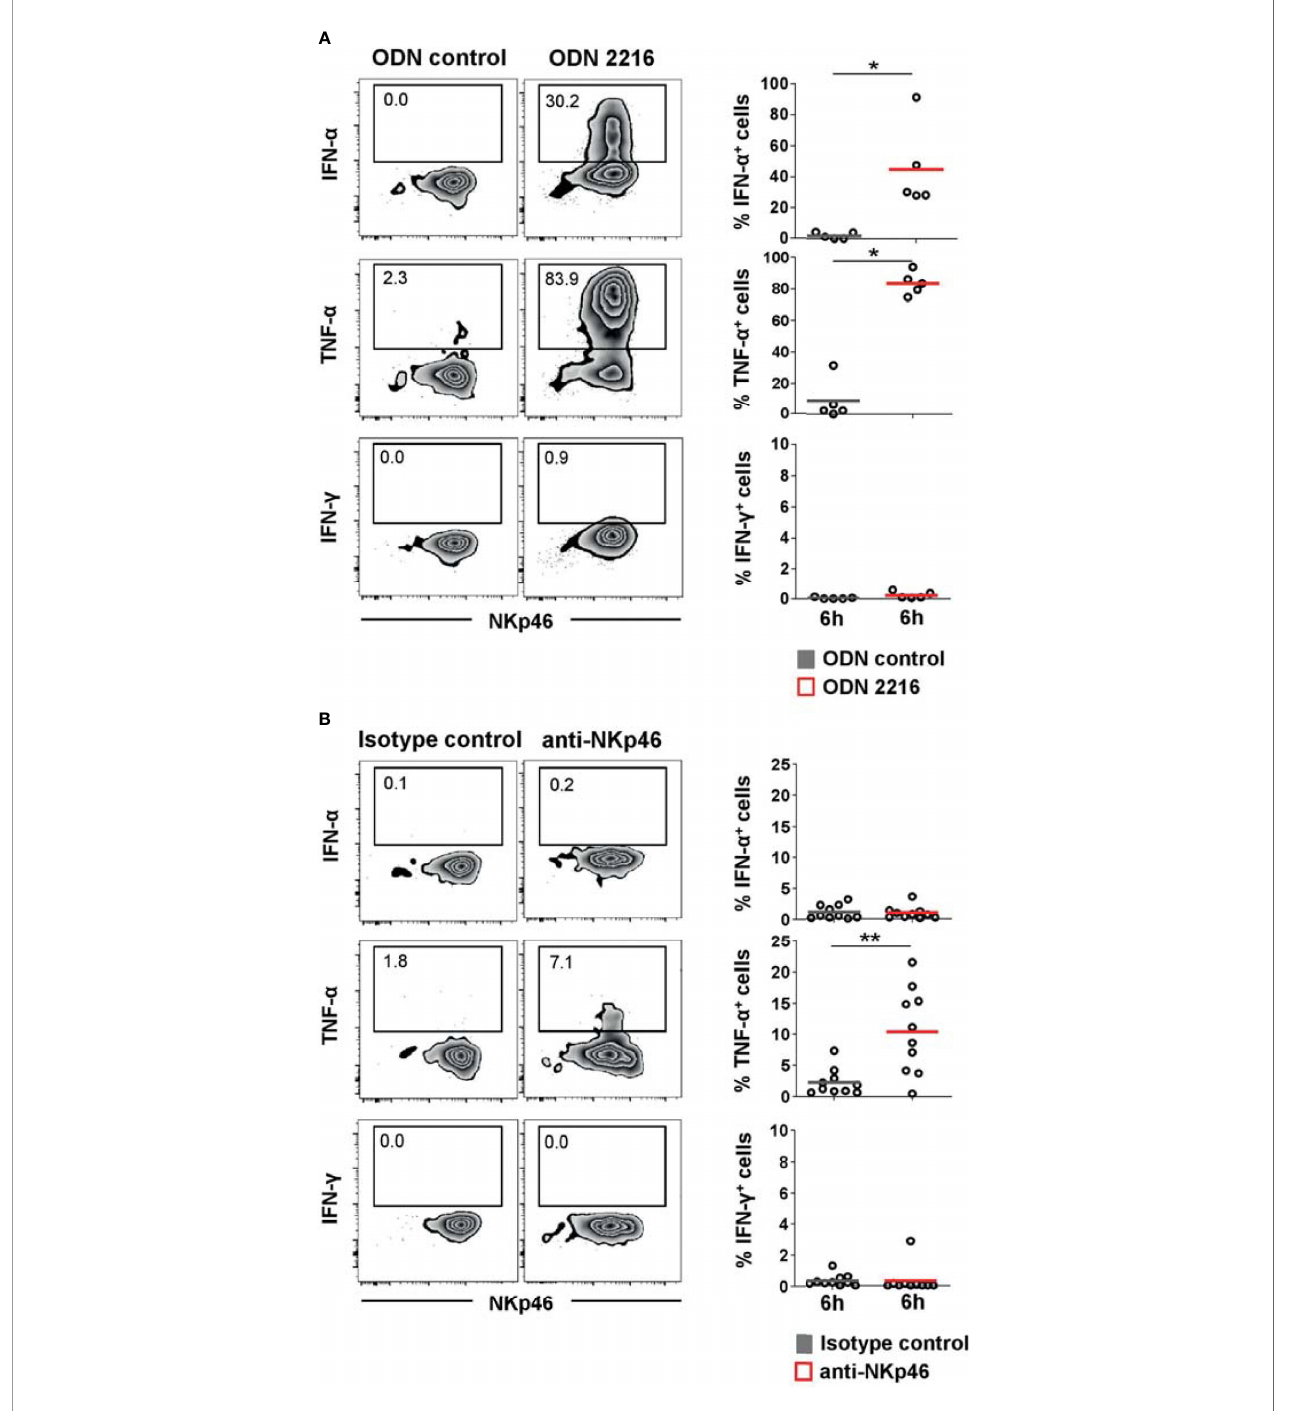
FIGURE 3 | Cytokine induction in pDCs after stimulation with TLR9 agonist or NKp46 triggering. Intracellular staining of IFN- a , TNF- a , and IFN- g was performed in PBMC of individual animals and is shown for CD4 high CD172a low pDCs. (A) PBMC were stimulated for 6 h either with the TLR9 agonist ODN 2216 (red) or incubated with non-stimulatory oligonucleotides (ODN control, gray). (B) Induction of cytokine production by receptor triggering was assessed in response to cross-linking of NKp46 after a 6-h incubation of PBMC with plate-bound mAbs (red). Plates coated with isotype-matched irrelevant antibodies served as control (gray). (A, B) Zebra plots on the left show cytokine production after stimulation for one representative animal; percentages of cytokine producing cells are indicated in the graphs. Frequencies of cytokine-producing cells within pDCs are shown for analyses of fi ve (A) or ten (B) animals in the graphs on the right. Mean values are represented by colored bars. Signi fi cant differences between stimulated and non-stimulated cells are indicated (* p ≤ 0.05 , ** p ≤ 0.01